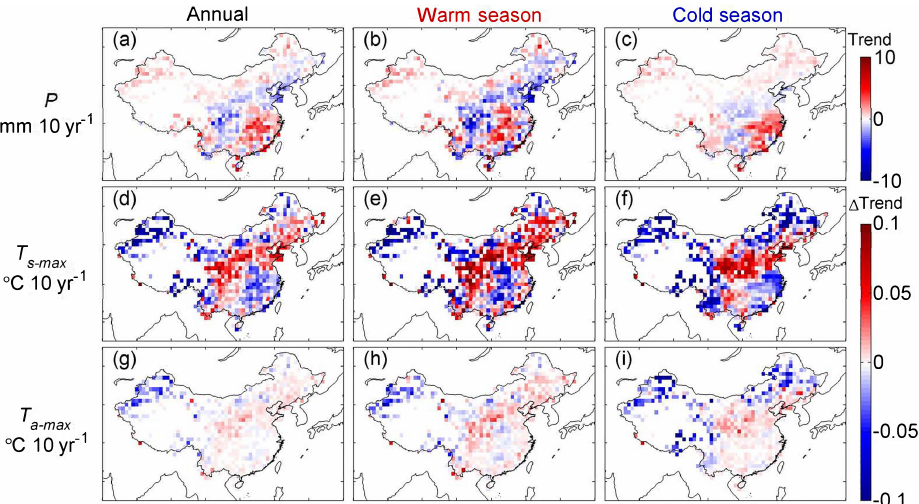
Figure 6. Maps of the trends in precipitation ( P) (a–c) and their effect on the warming rates for daily maximum land surface temperature ( T s-max , (d–f) ) and daily maximum air temperature ( T a-max , (g–i) ). The first line (a–c) is the trends of P during 1960–2003; the second line (d–f) and the third line (g–i) are the trend changes caused by secular variations in P on T s-max and T a-max . We used Eq. (1) to remove the effects of P on the temperatures, then calculated the trend difference ( (cid:49) Trend, (d–i) between the time series of temperatures before and after adjusting for the effect of P . Finally, the effect of P on the trends of T s-max and T a-max was quantified and analyzed (Sect.